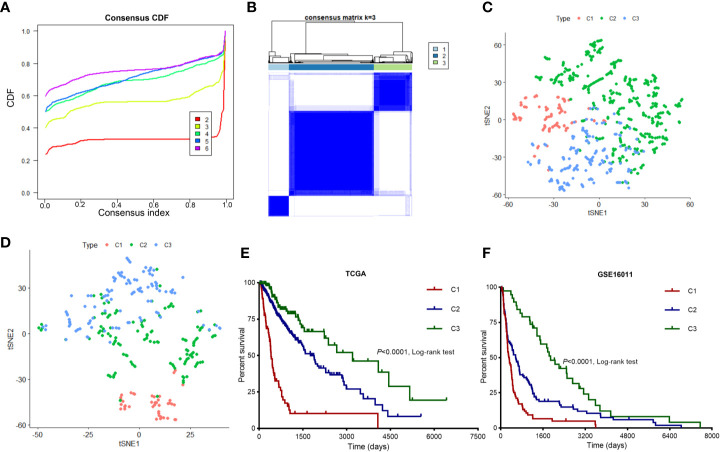
Identification of immune-related subtypes of diffuse glioma in TCGA cohort. (A) The cumulative distribution function (CDF) curves in consensus cluster analysis. Consensus scores for different subtype numbers (k = 2 to 6) are presented. (B) The heatmap illustrating the consensus matrix at k = 3 in TCGA cohort. (C, D) The stratification into three subtypes validated by t-SNE in TCGA and GSE16011 cohorts. Each dot represents a single sample, and each color denotes a subtype. (E, F) Survival analysis of patients with the three diffuse glioma subtypes (C1, C2, and C3) in TCGA and GSE16011 cohorts. The log-rank test was conducted to determine the significance of the differences.